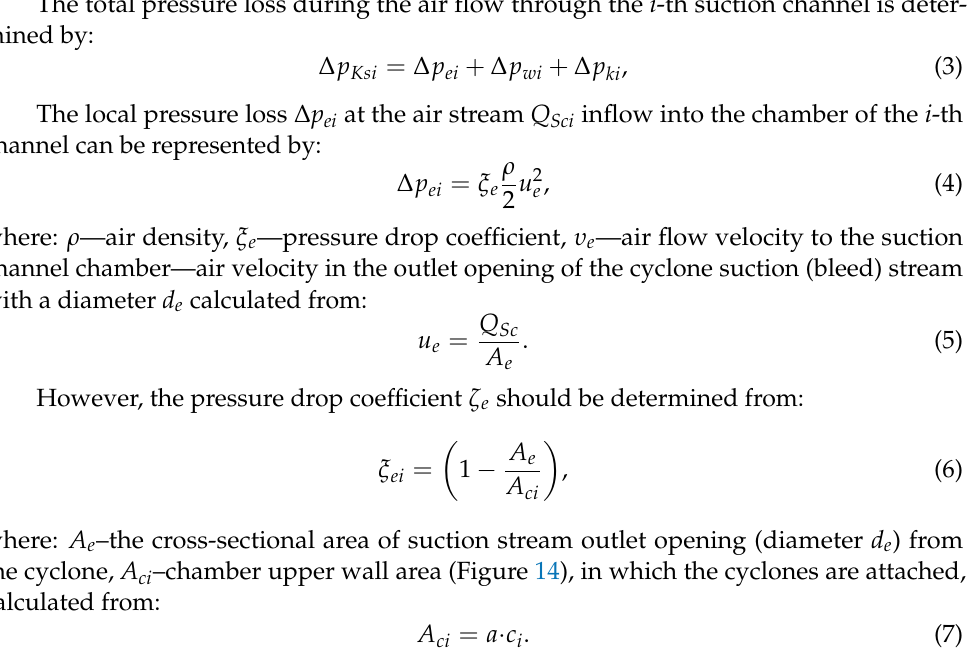
Figure 13. Schematic diagram of the air filter multi-cyclone settling tank segment: K S —suction channel, R —chamber.